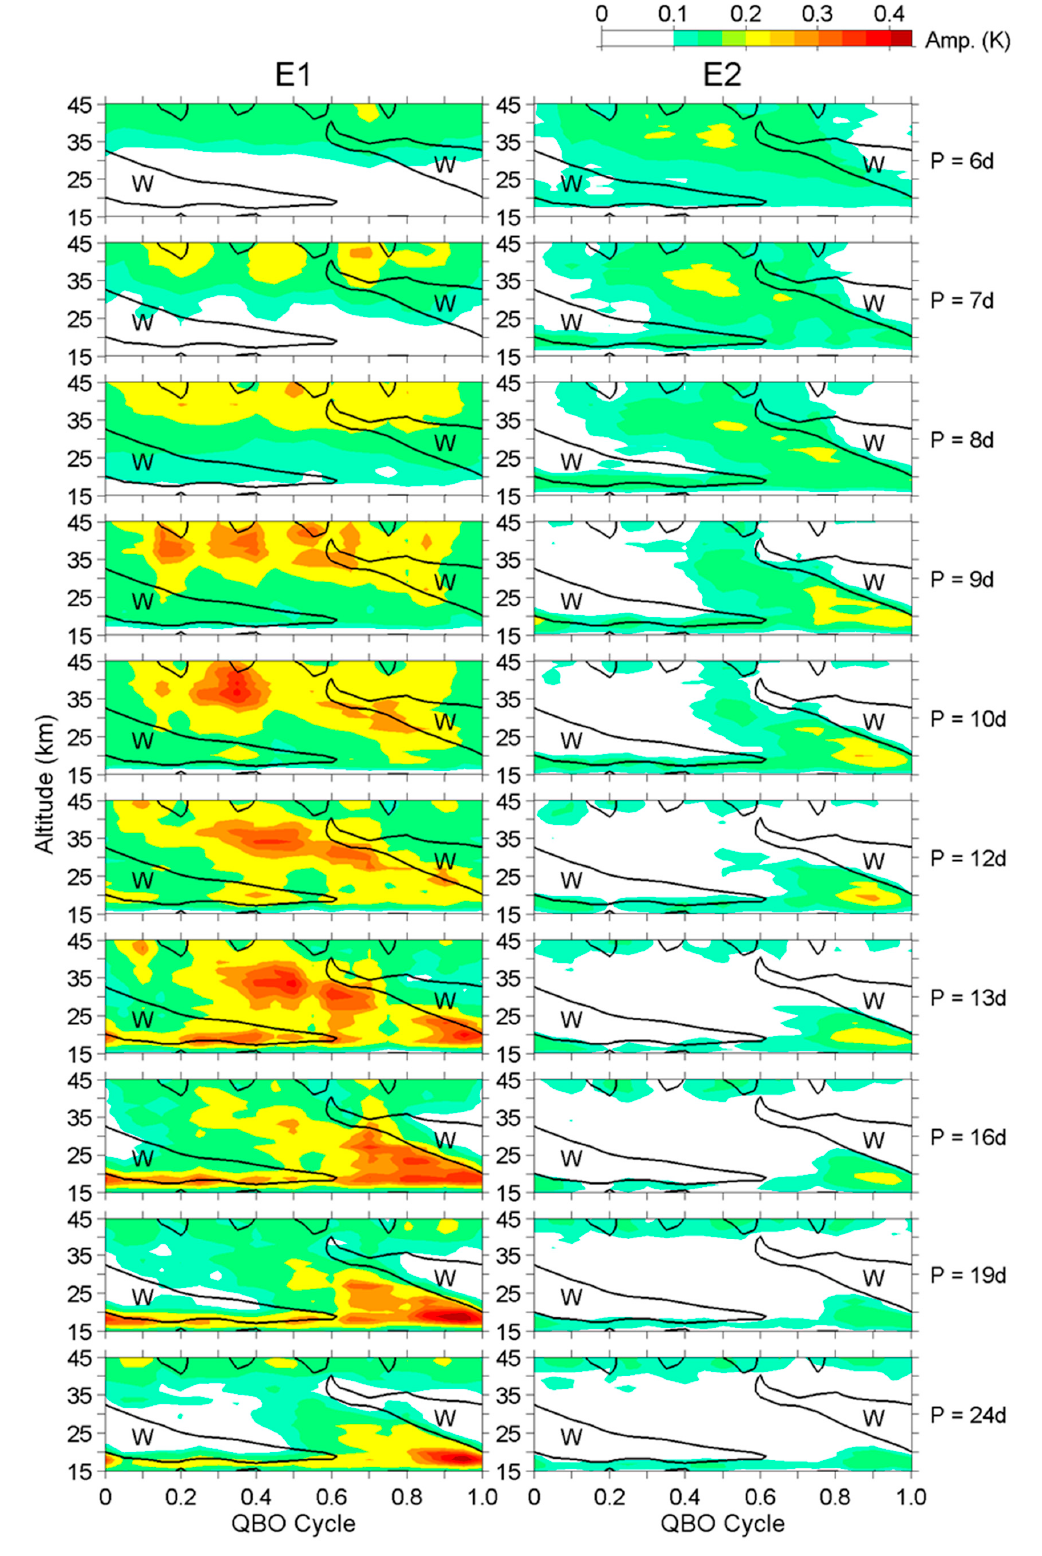
Figure 6. The time-averaged amplitudes of E1 and E2 waves (columns) at periods ranging from 6 to 24 days (rows). The elapsed time is standardized to 0–1 QBO cycle (~29.4 months). The zero-wind of the time-averaged zonal wind is also plotted by black lines in each panel, and the westerly regimes of the time-averaged zonal wind are identified.